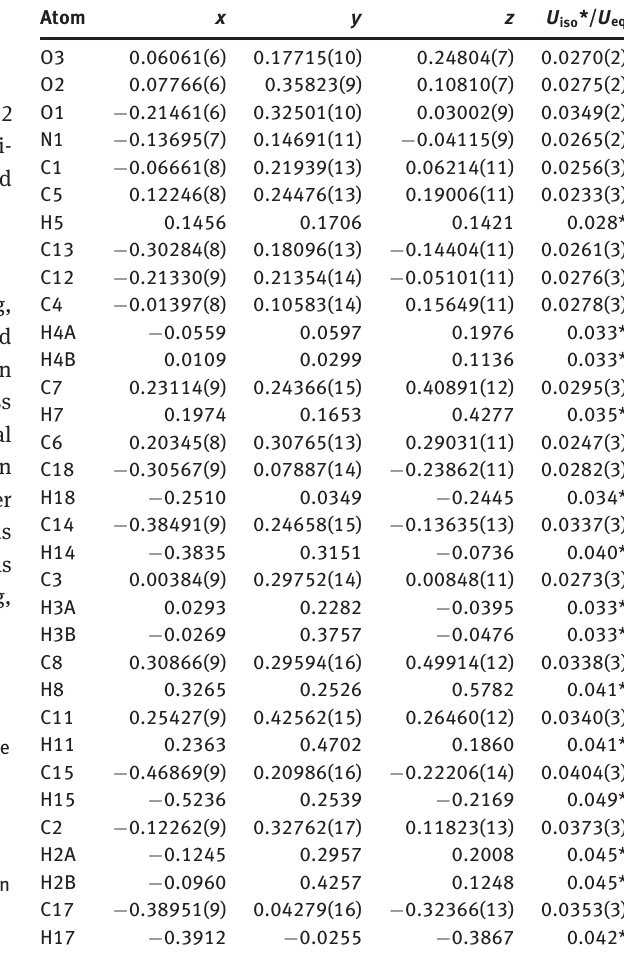
Table 2: Fractional atomic coordinates and isotropic or